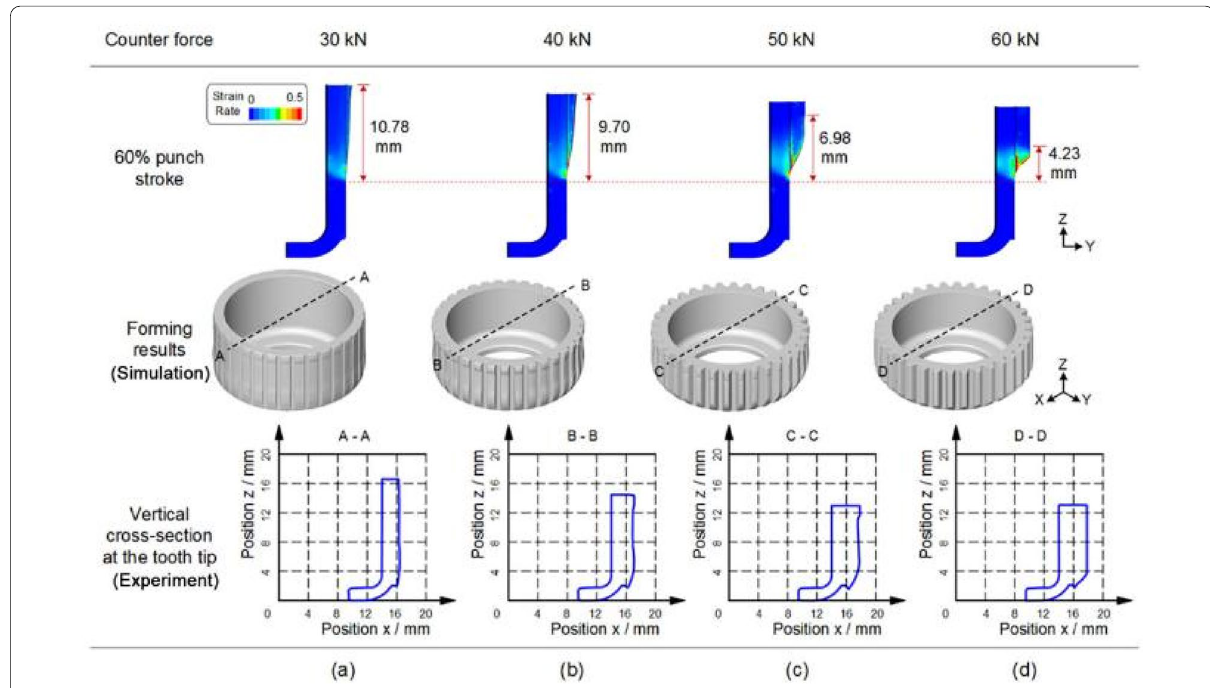
Figure 14 Forming analysis and results under different counter forces: ( a ) 30 kN, ( b ) 40 kN, ( c ) 50 kN, ( d ) 60